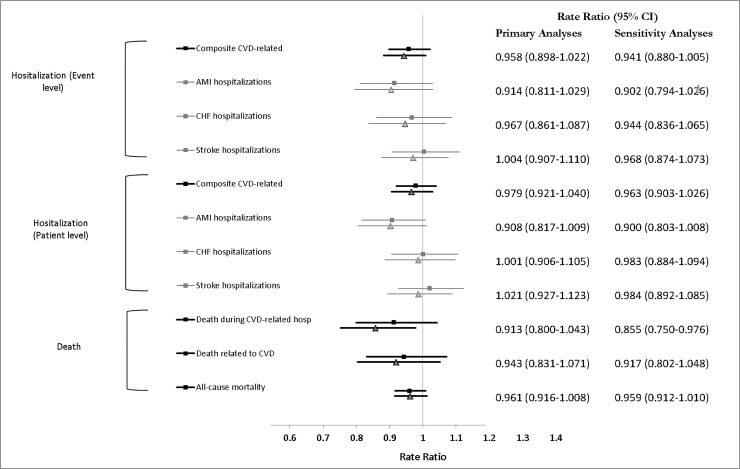
Forest plot showing the results of the negative binomials rate ratios and Cox (hazard ratios) regressions.Primary analyses are results of regressions established a priori and in which the baseline rate for that event is used as the offset (Rate Ratio) or as a covariate in the model (Hazard Ratio), and where the clustering of individuals within the community is accounted for. Sensitivity analyses also included the rurality category (<10, 10–45, >45). These were planned a posteriori, after identifying a meaningful difference in the rurality index of the two groups of communities. Cox regressions were conducted for “Patient level” outcomes only, while negative binomial regressions were carried out for both “Patient level” and “Event level” outcomes. All measures reflect the rate of the event in the intervention communities compared to the control communities. An estimate smaller than 1 points to a benefit for the intervention arm.